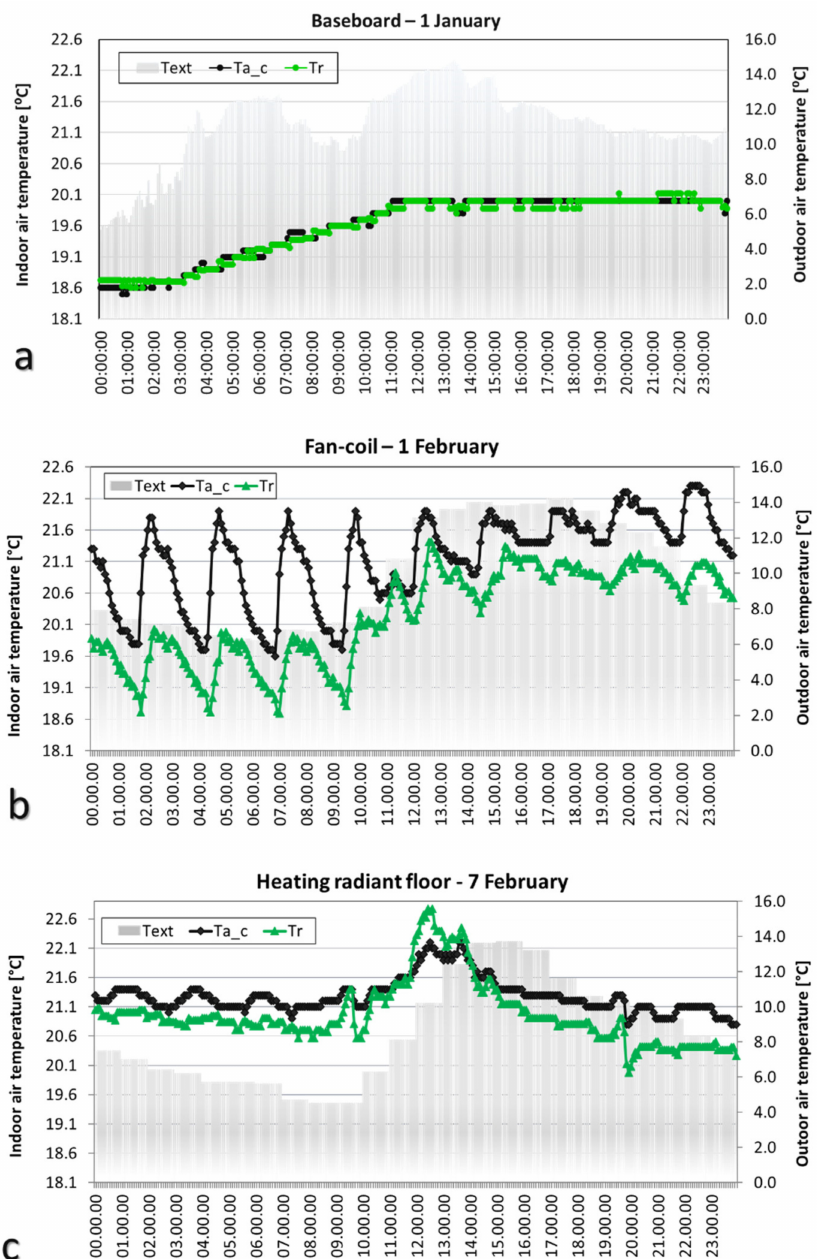
Figure 2. Recorded temperatures in the center of room: ( a ) baseboards; ( b ) fan-coil units; ( c ) radiant heating